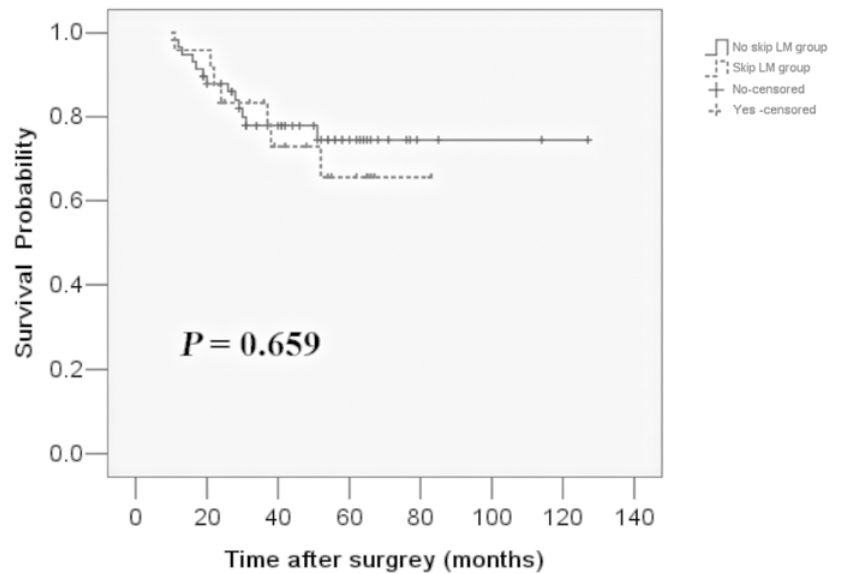
Figure 1. The 5-year survival of the groups between the skip LM patients and the other SLM patients is 65.6% and 74.5, respectively. The log-rank test revealed there was no significant difference between the two curves ( χ 2 = 0.195, P = 0.659).